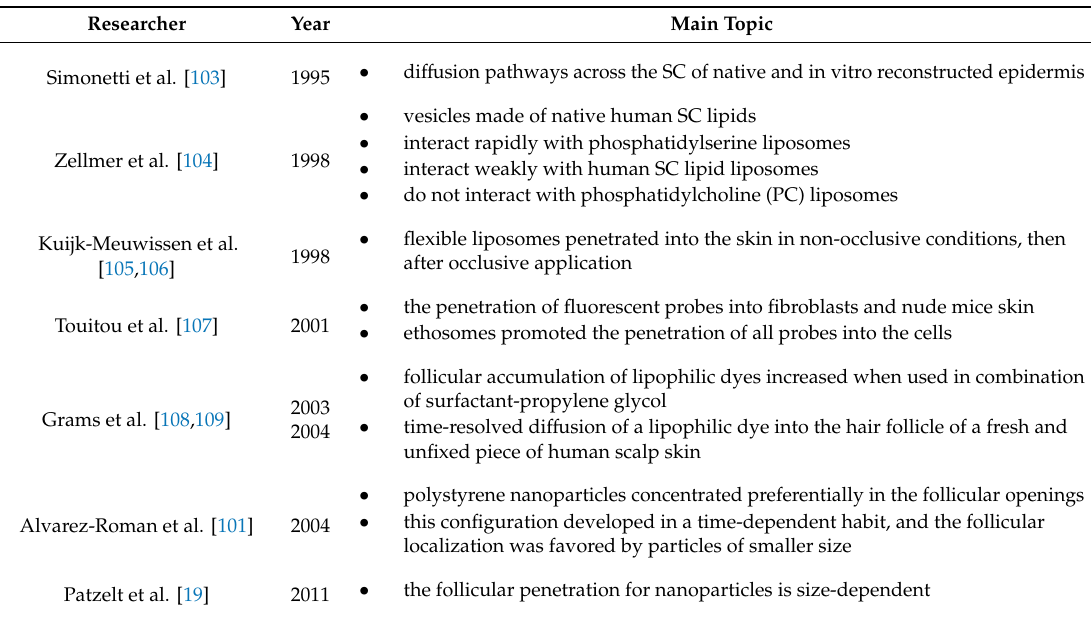
Table 5. Confocal laser scanning microscopy